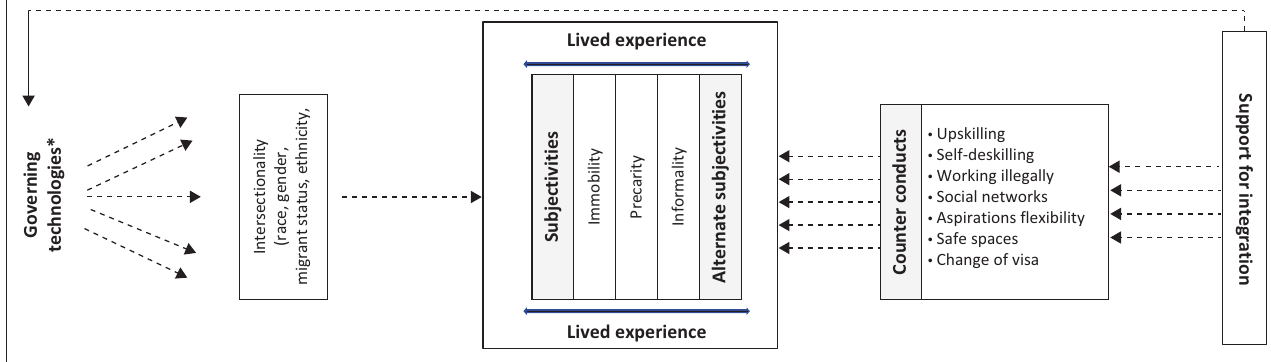
FIGURE 1: Framework for labour market integration of accompanying